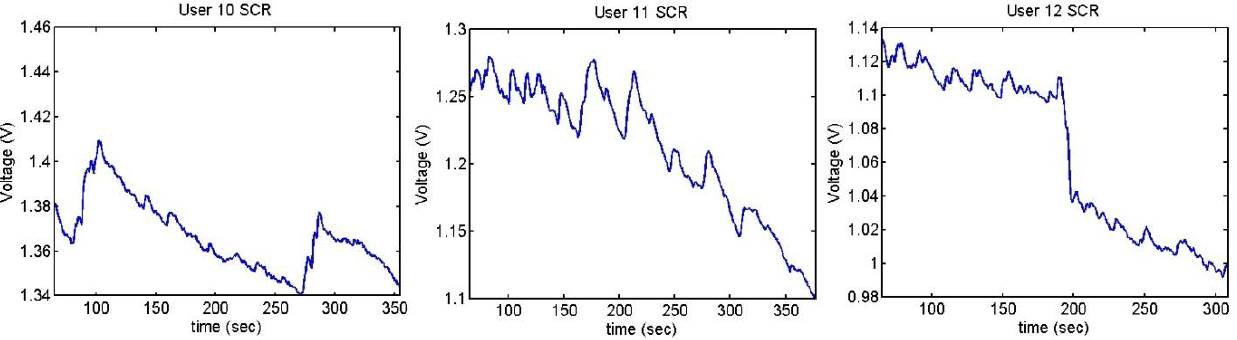
Figure 35. Skin response of users 10, 11 and 12 from Sounds